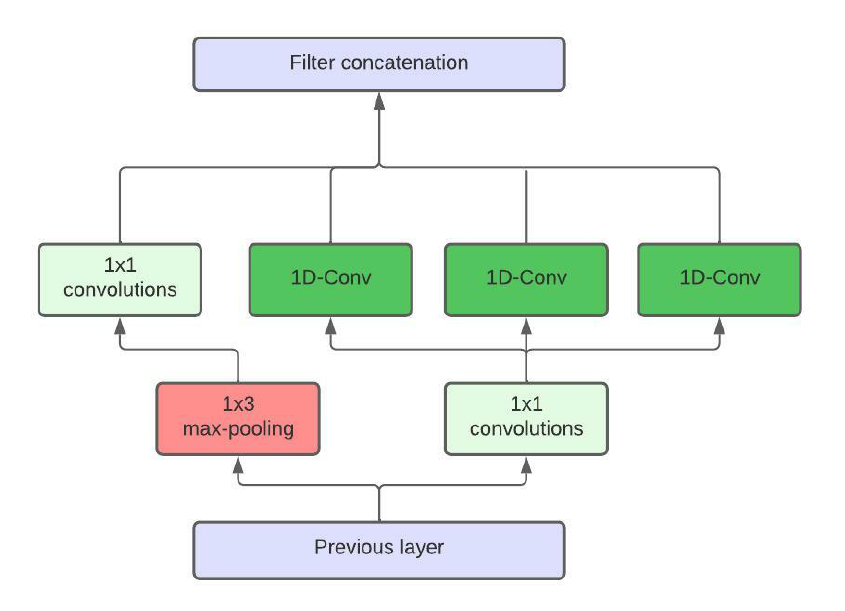
Figure 4. Our Inception module for the time series segmentation. Note that the three 1D-Conv blocks marked in green have different receptive